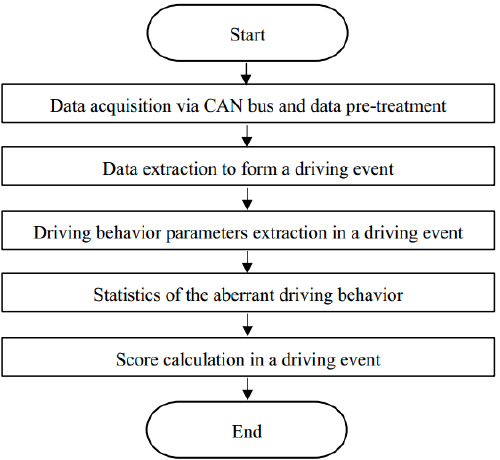
Figure 17. The evaluation flow chart of driving behaviour.